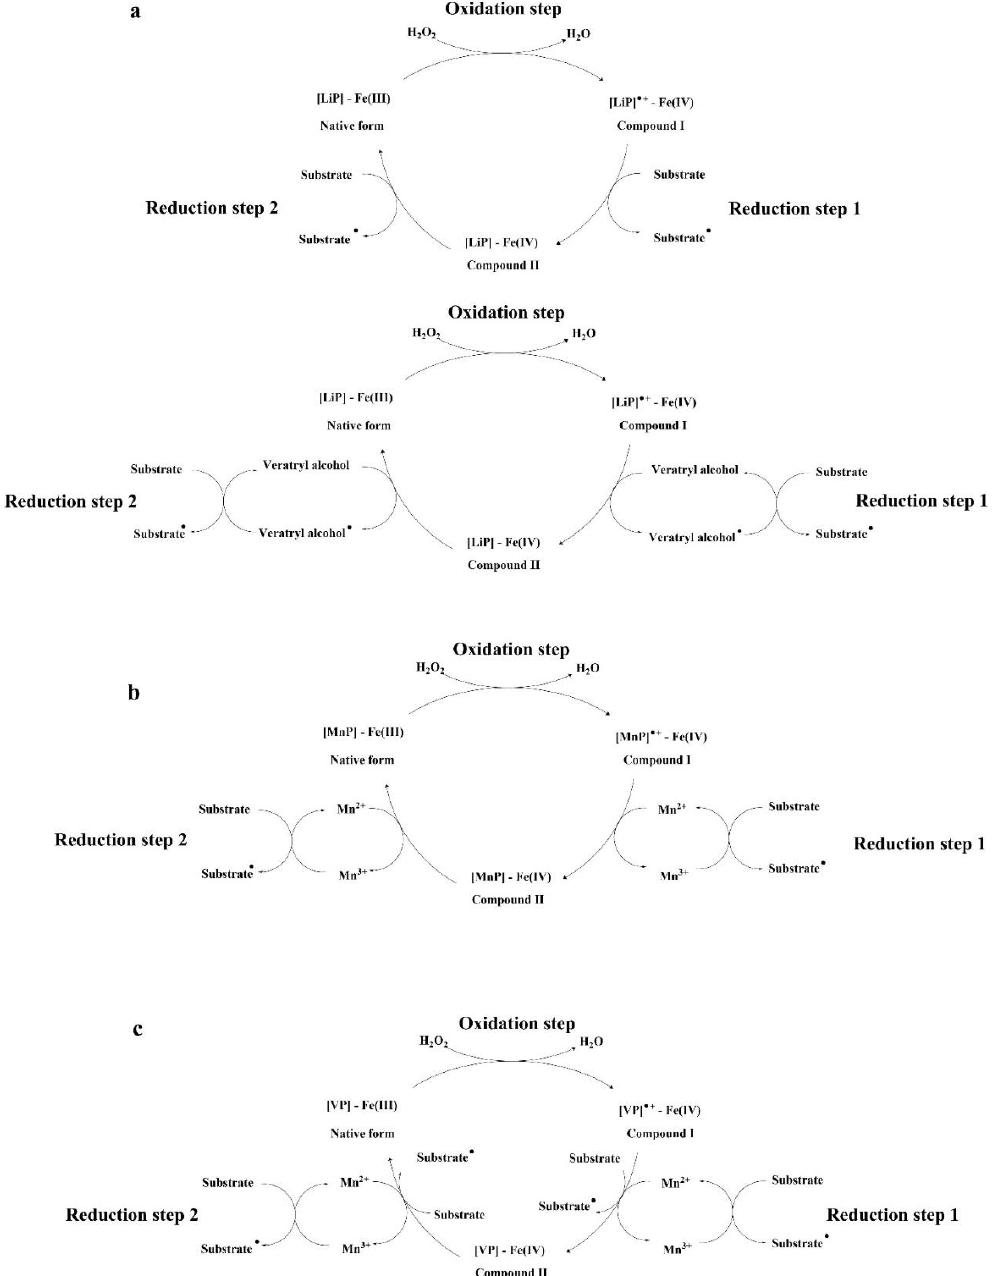
Figure 3. Schematic representation of the catalytic mechanism of LiP, MnP and VP. LiP ( a ), MnP ( b ) and VP ( c ) require H 2 O 2 for the oxidation of substrates, with veratryl alcohol and Mn 2+ being used as facultative mediators for LiP and VP, respectively.